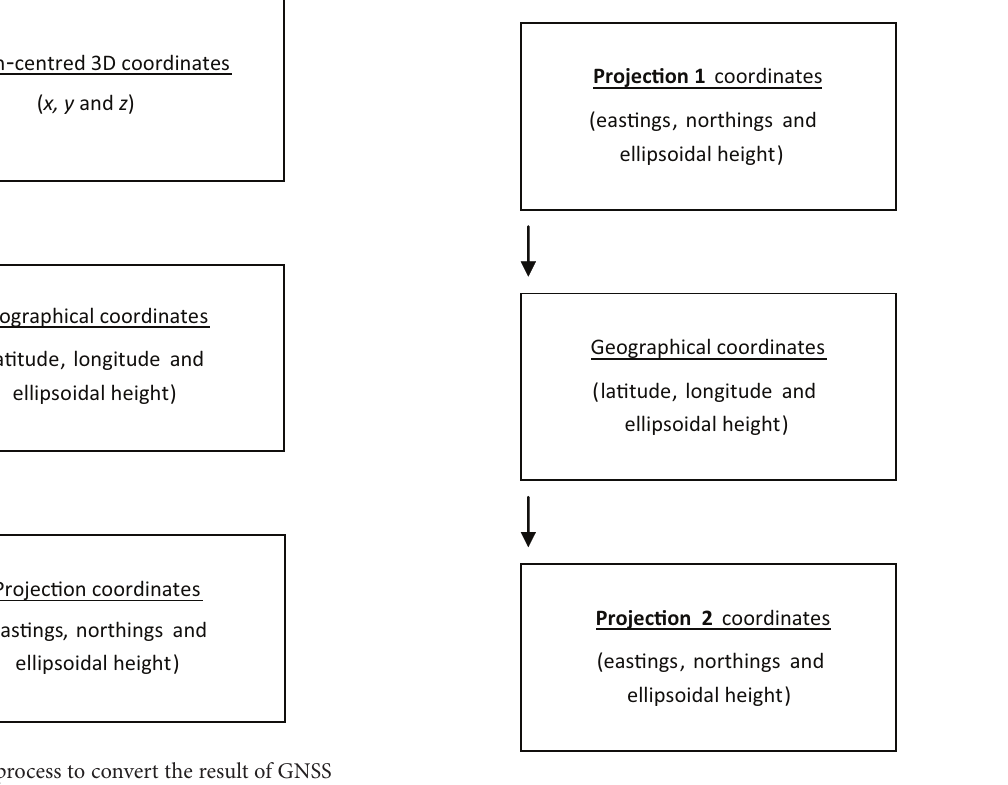
Fig. 2. The process of obtaining projection coordinates in